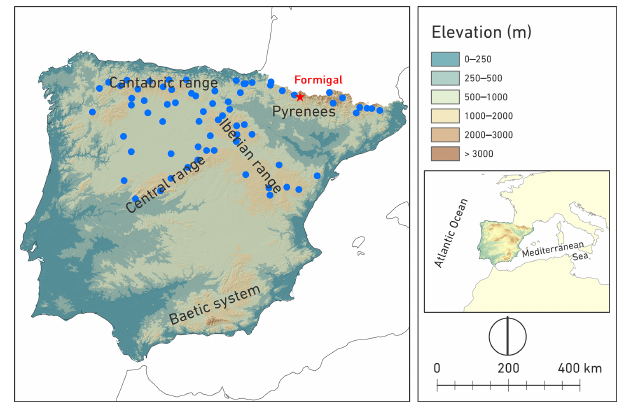
Figure 2. Orography of Spain and location of the Formigal–Sarrios site. Blue points indicate the location of automatic weather stations in the operational